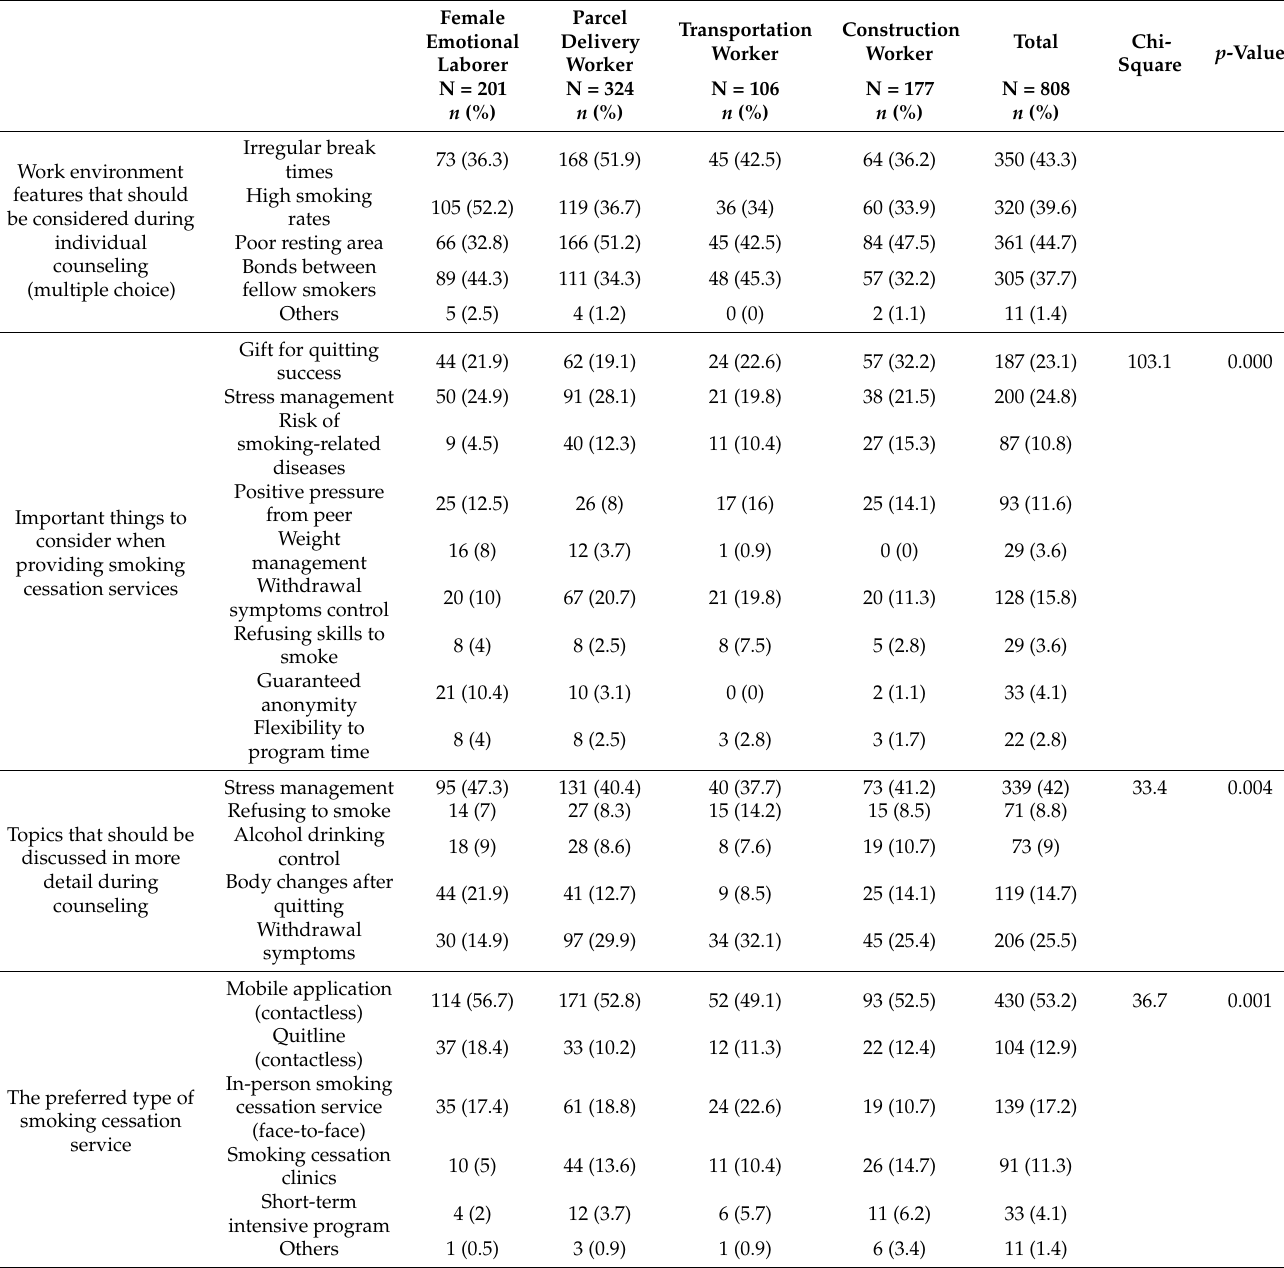
Table 4. Need for smoking cessation